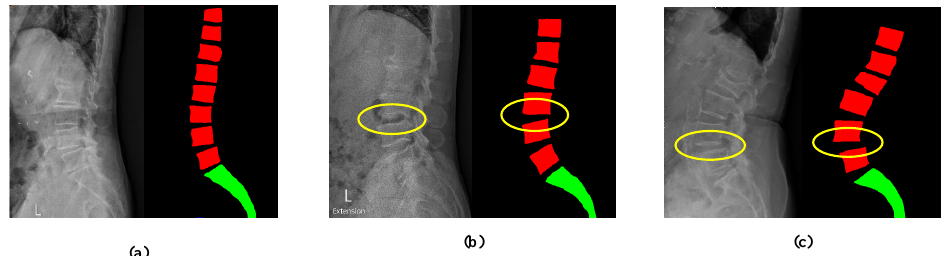
Figure 13. Performance of LumbarNet in the detection of lumbar spondylolisthesis: ( a ) No Spondy- lolisthesis, ( b ) Spondylolisthesis at L 3- L 4, ( c ) Spondylolisthesis at L 4- L